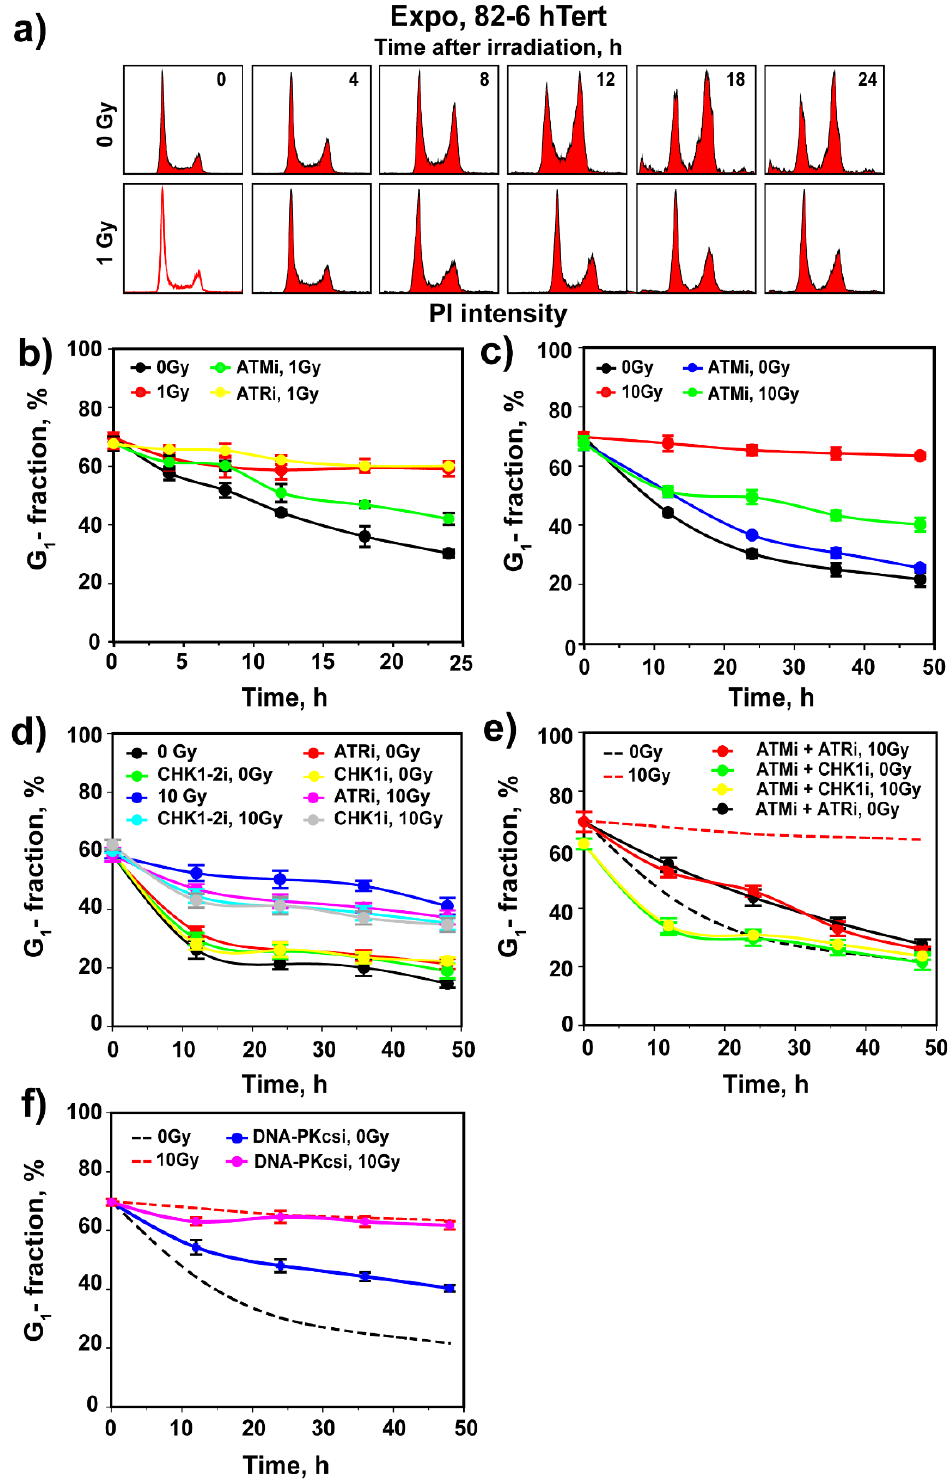
Figure 1. Assessment of G 1 checkpoint in irradiated G 1 cells of exponentially growing 82-6 hTert cell cultures. ( a ) Histograms showing cell cycle distribution as a function of time after exposure to 0 or